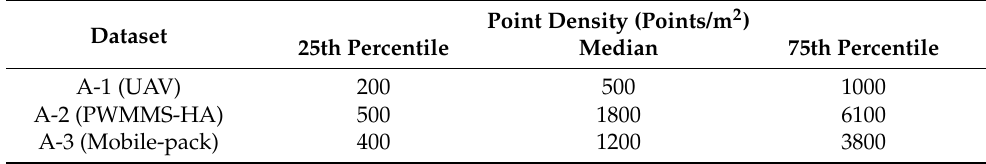
Table 6. Estimated vertical discrepancy ( d z ) and square root of a posteriori variance ( ˆ σ 0 ) using A-1 (UAV), A-2 (PWMMS-HA), and A-3 (Mobile-pack)